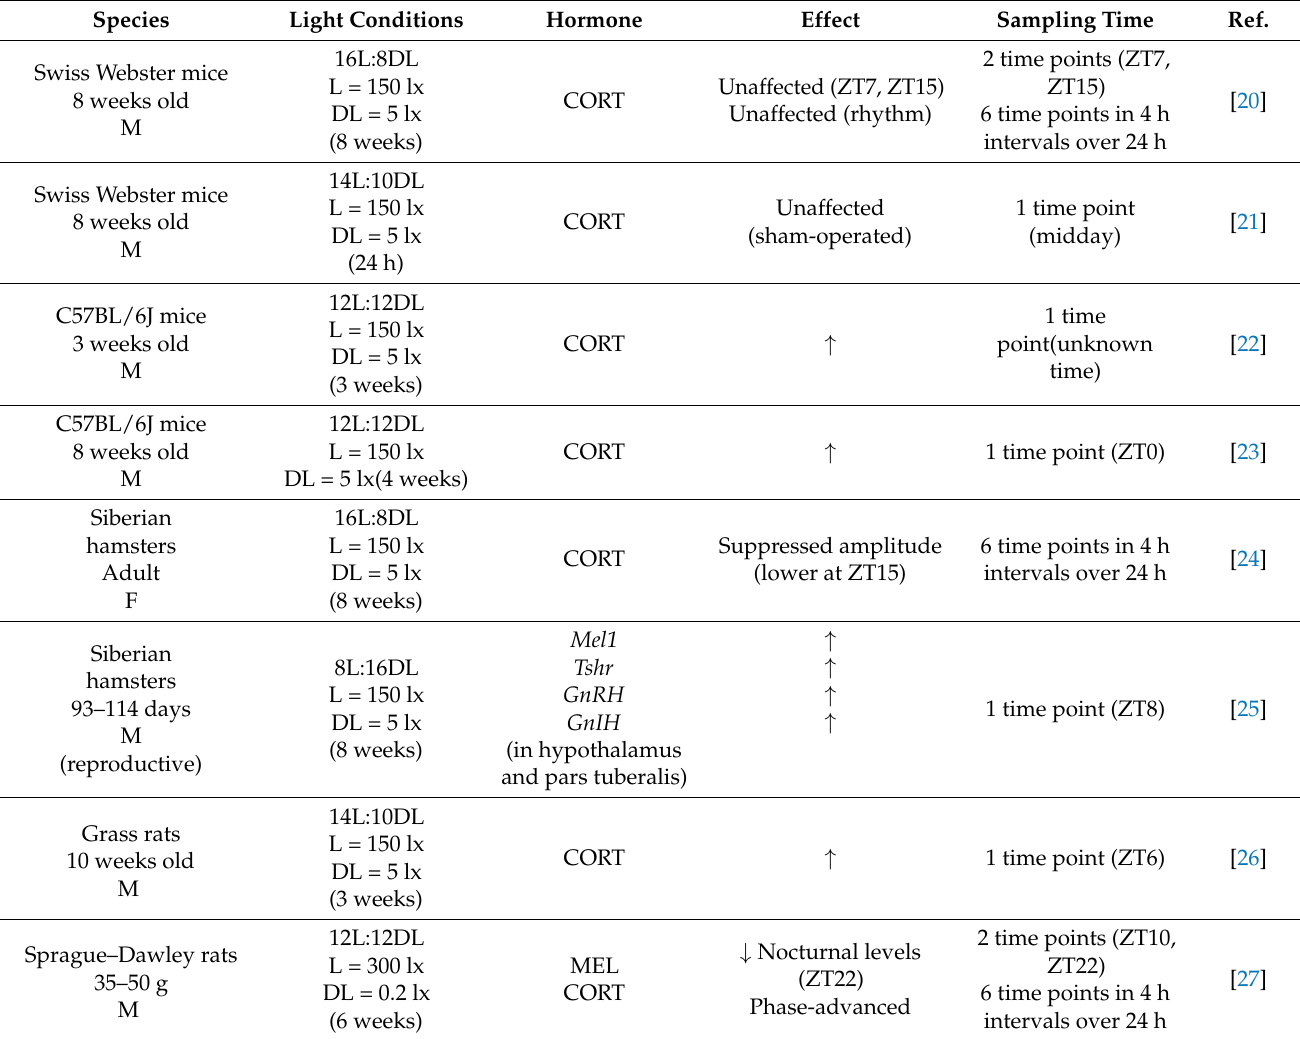
Table 1. Effects of dim artificial light at night (ALAN) on hormones. AVP = arginine vaso- pressin. CORT = corticosterone. CTRL = control group. DL = dim light phase. F = female. GnIH = gonadotropin-inhibiting hormone. GnRH = gonadotropin-releasing hormone. L = light phase. lm = lumen. M = male. MEL = melatonin. Mel1 = melatonin receptor 1. SHR =